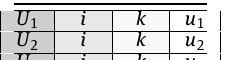
Table 6. Index distribution of the codewords of G ik ∪ D ik ∪ E ik . V